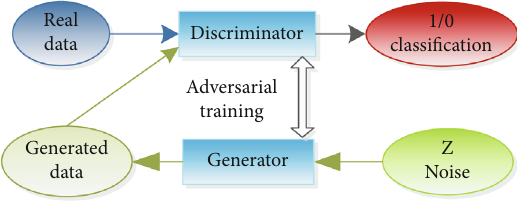
Figure 1: The schematic diagram of